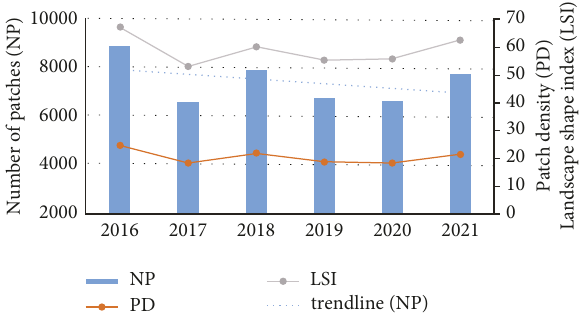
Figure 6: Changes in landscape pattern indices (NP, PB, and LSI) of Baiyangdian Wetland from 2016 to